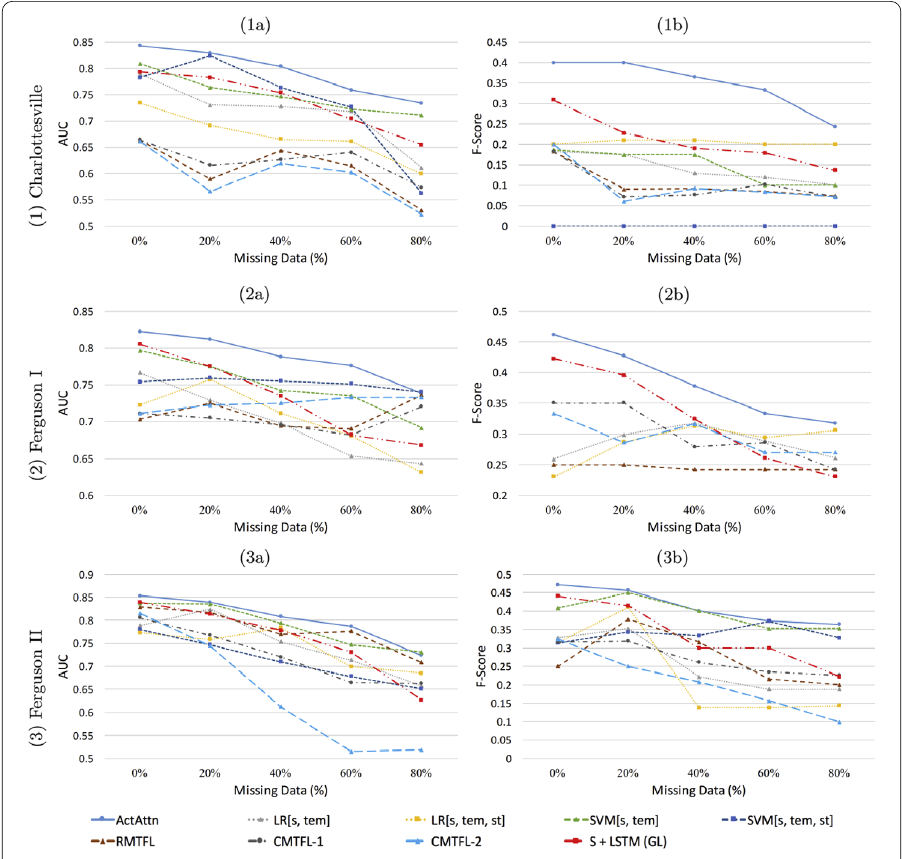
Figure 3 Forecasting results against varying levels of missingness (in time and space) from the test sets. The x -axes indicate the levels of missingness, and the y -axes indicate the performance in terms of ( a ) AUC